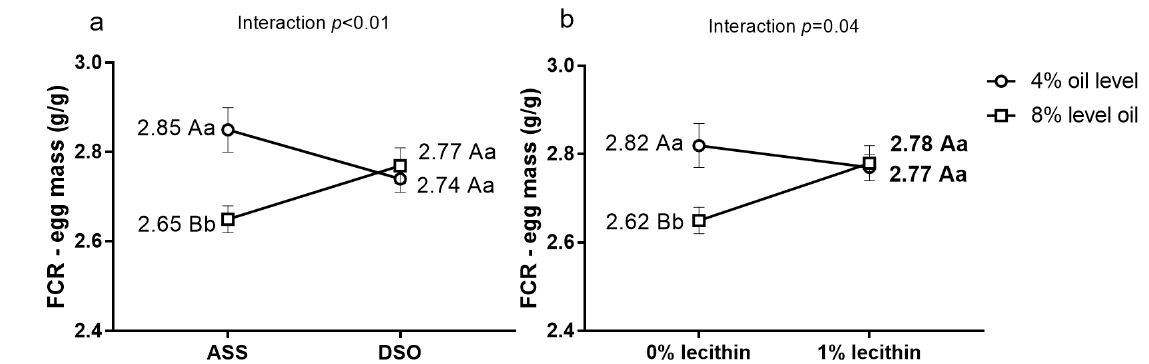
Figure 3. Effect of interaction between type of oil and level oil on FCR (3a) and interaction between presence or absence of lecithin and level oil on FCR (3b) of Japanese quails. (a): Different lowercase letters are significantly different between type of oil; Different capital letters are significantly different between level oil. (b): Different lowercase letters are significantly different between presence or absence of lecithin; Different capital letters are significantly different between level